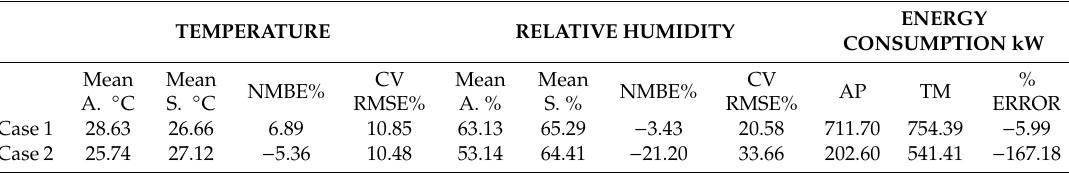
expressed as actual data (A) and simulated data (S).